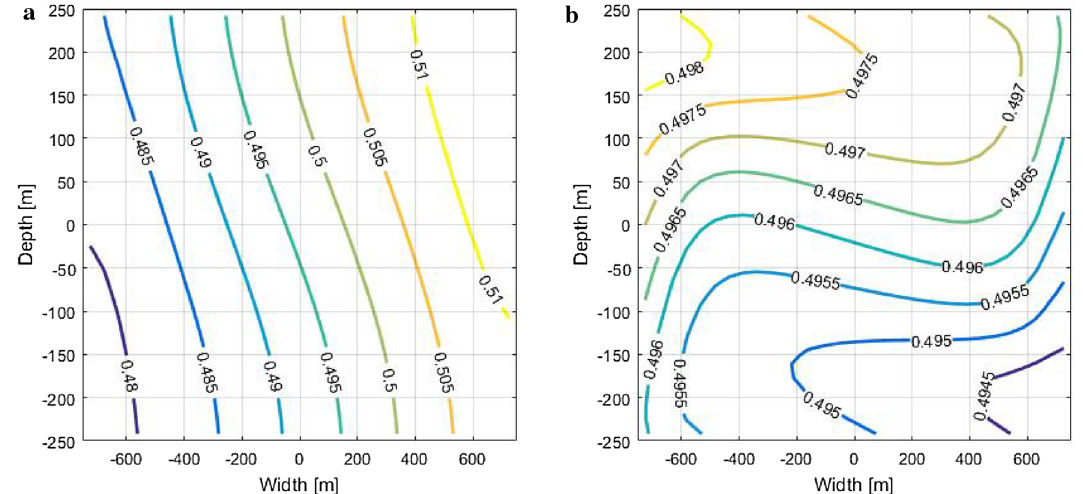
Fig. 9 a Contour plot of C 1 composition, convection-free, volatile oil. b Contour plot of C 1 composition, with natural convection, tile